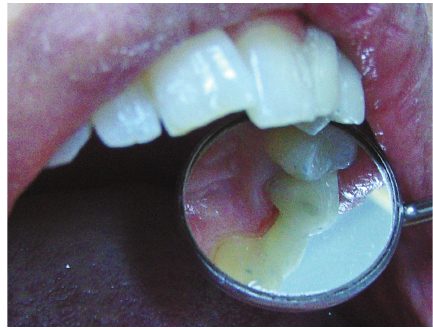
Figure 6: Palatal view of the final restoration.